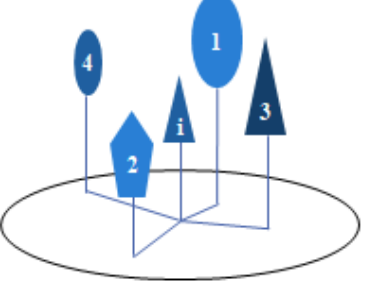
Figure 1. Stand spatial structural unit. i is the reference tree, and 1, 2, 3 and 4 are the four nearest neighbor trees.